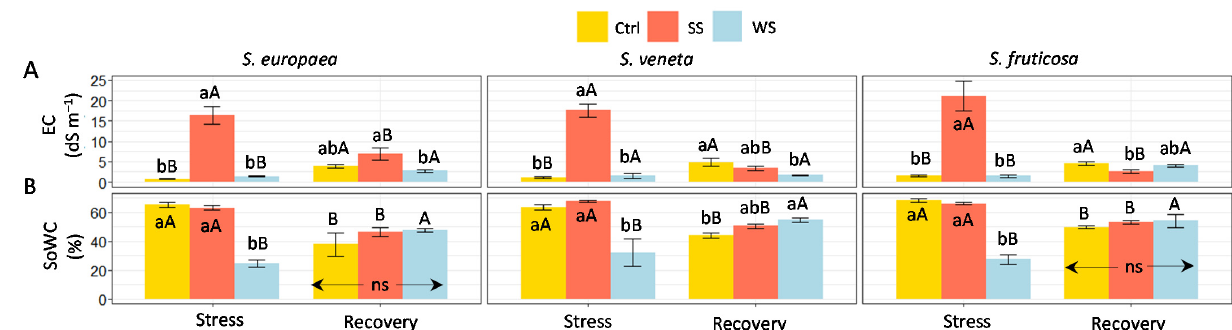
Figure 1. Effect of 30 days of stress treatments (Stress), followed by watering with non-saline water for 15 days (Recovery) on ( A ) Substrate electrical conductivity (soil EC) and ( B ) water content (soil WC). Ctrl, control; SS, salt stress (watering with 700 mM NaCl); WS, water stress (complete withholding of irrigation). For each species and sampling (Stress or Recovery), different lowercase letters over the bars indicate significant differences between treatments (Ctrl, SS, and WS) at p ≤ 0.05. Different uppercase letters indicate significant differences between the two sampling times (Stress and Recovery) for each species and treatment, at p ≤ 0.05. Vertical bars indicate standard error ( n = 4). ns: non-significant.